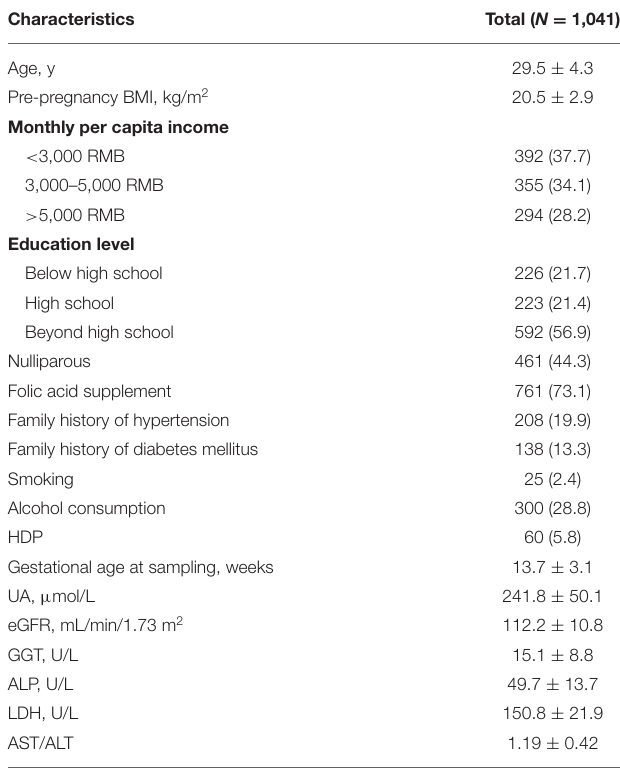
TABLE 1 | Baseline characteristics of the study